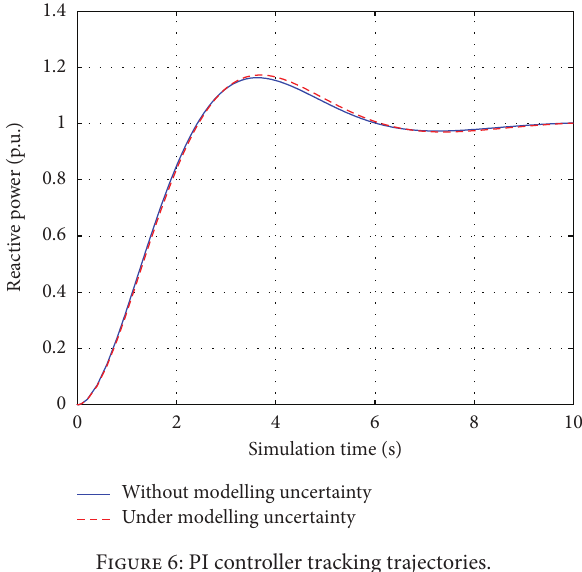
Figure 6: PI controller tracking trajectories.